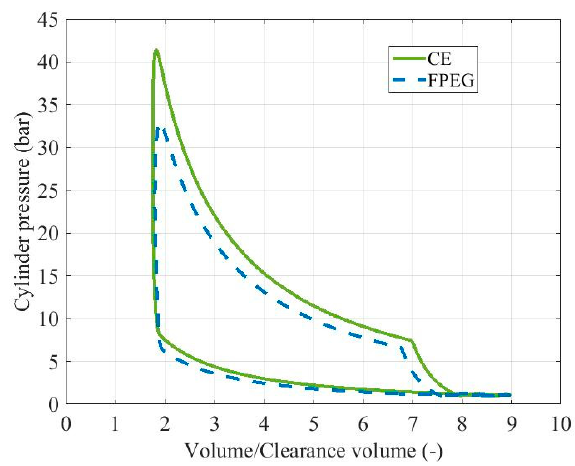
Figure 12. p-V diagram of FPEG and CE with the same valve timing.